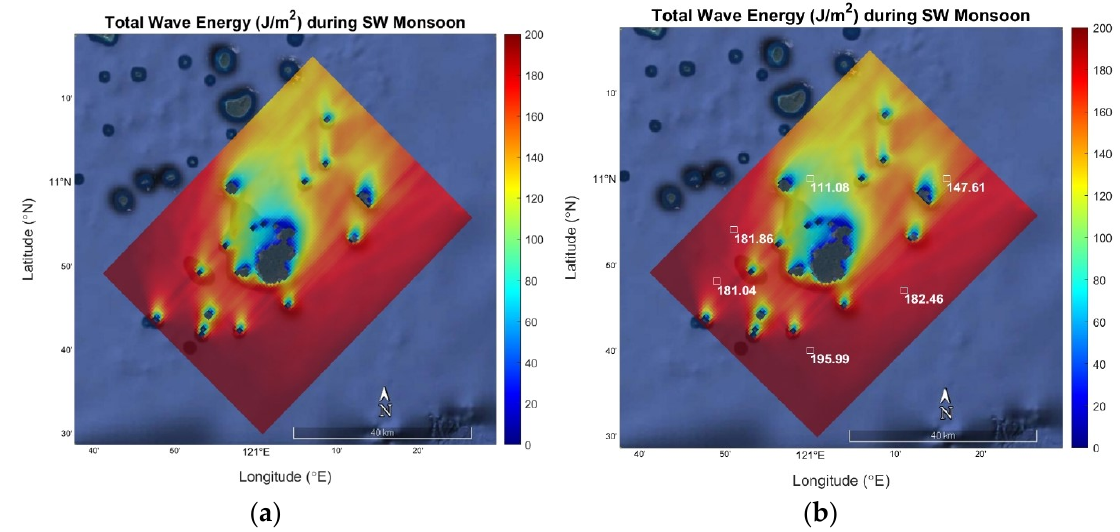
Figure 21. ( a ) Wave energy (J/m 2 ) model during southwest monsoon season and ( b ) wave energy model indicating the total wave energy at stations A–F during the season.